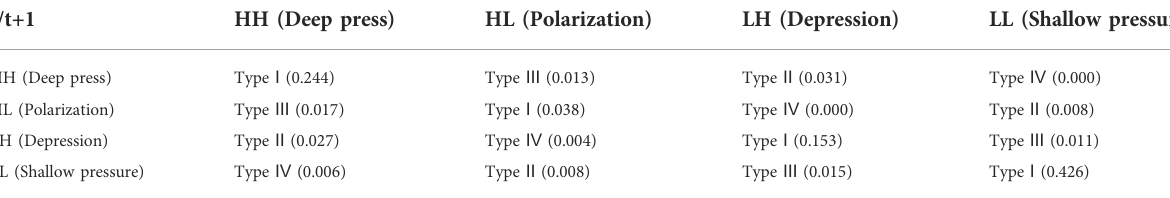
TABLE 5 Spatial and temporal leap matrix of net carbon emissions.